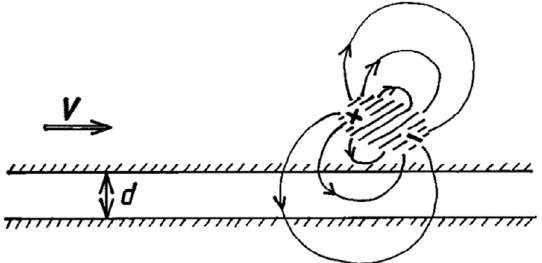
Fig. 4 Diagram of Coulomb drag between two closely-spaced solids. Reproduced with permission from Ref. [50], © The American Physical Society